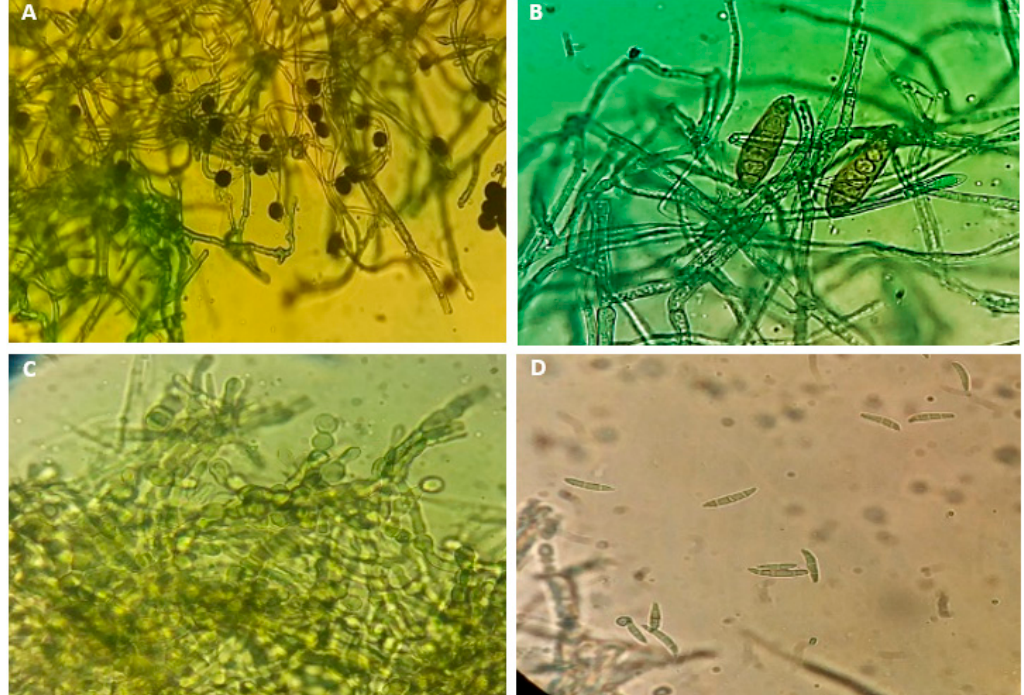
Figure 3. Morphological characteristics of the conidia, N. lacticolonia ( A ), E. rostratum ( B ), chlamydospores and conidia of F. oxysporum (( C , D ), respectively) and conidia of F. solani at 40× magnification.